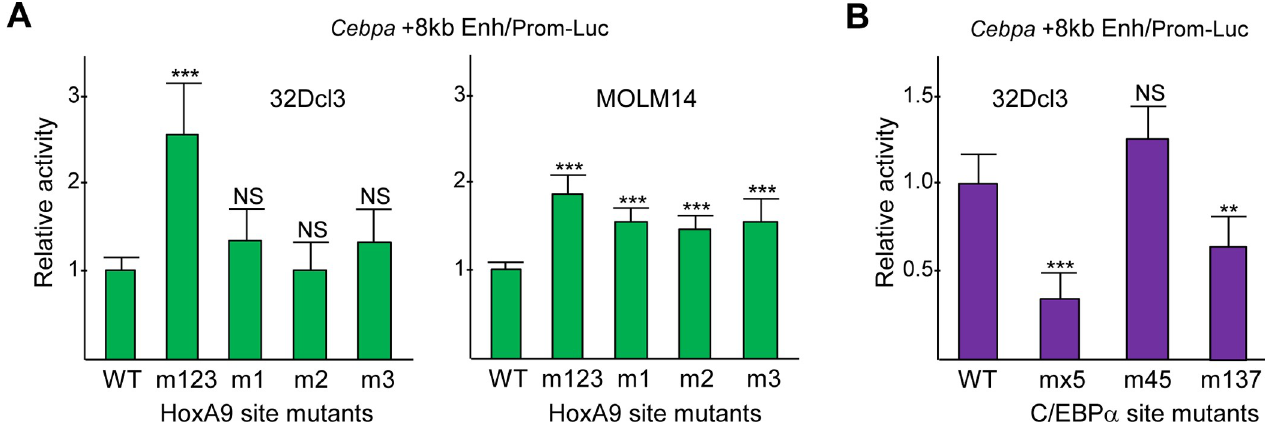
Fig 6. HoxA9 represses and C/EBP α activates the Cebpa +8 kb enhancer in immature myeloid cells. A) 32Dcl3 murine myeloid progenitor or MOLM14 human AML cells were transfected with wild-type (WT) Cebpa +8 kb Enh/Prom-Luc or with mutant variants harboring 2 bp point mutations in HoxA9-binding sites 1, 2, and 3 (m123), or in sites 1, 2, or 3 alone (m1, m2, m3), together with CMV- β Gal as internal control for 32Dcl3 cells. The relative activity of each reporter is shown, with the activity of the WT reporter set to 1.0 in each experiment (mean and SD from six determinations for 32Dcl3 and nine for MOLM14). B) 32Dcl3 cells were transfected with WT Cebpa +8 kb Enh/Prom-Luc or with mutant variants harboring 2 bp point mutations in C/EBP α - binding sites 1, 3, 4, 5, and 7 (mx5), 4 and 5 (m45), or 1, 3, and 7 (m137), with CMV- β Gal. The relative activity of each reporter is shown, with the activity of WT reporter set to 1.0 in each experiment (mean and SD from nine